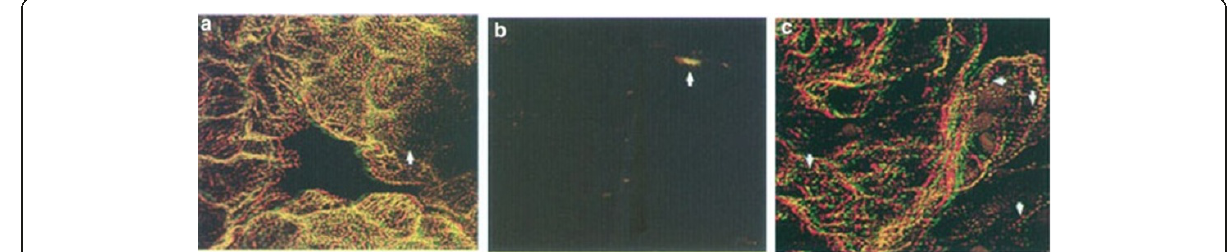
Figure 2 Sarcomeric tropomyosin expression in normal, mutant, and TPM1 α -transfected mutant hearts. a . Confocal micrograph of stage-39 normal hearts stained with CH1 anti-tropomyosin antibdody (and rabbit anti-mouse lissamine rhodamine secondary antibody), well-organized sarcomeric myofibrils can be seen throughout the ventricle of the heart (arrow). b . Heart from stage-39 mutant embryo stained with CH1 does not show any organized myofibril, Only small areas of amorphous staining can be visualized within the ventricle (arrow). c . Stage-36 mutant heart lipofected with an expression construct containing a murine TPM1 α cDNA under the control of α -Myosin Heavy Chain promoter, which subsequently induced TM and promoted myofibrillogenesis. Mutant heart stained with α -actinin primary antibody. Well-organized sarcomeric myofibrils can be seen throughout the heart (arrows). Staining of the Z-lines confirmed the sarcomeric organization seen in TPM1 α transfected hearts that were stained with tropomyosin primary antibody (results not shown here) [ref]. Interestingly, statge-36 mutant heart tansfected with a murine TPM2 α cDNA under the same promoter did express some TM protein but sarcomeric myofibrils did not form throughout the heart in contrast to TPM1 α transfected hearts